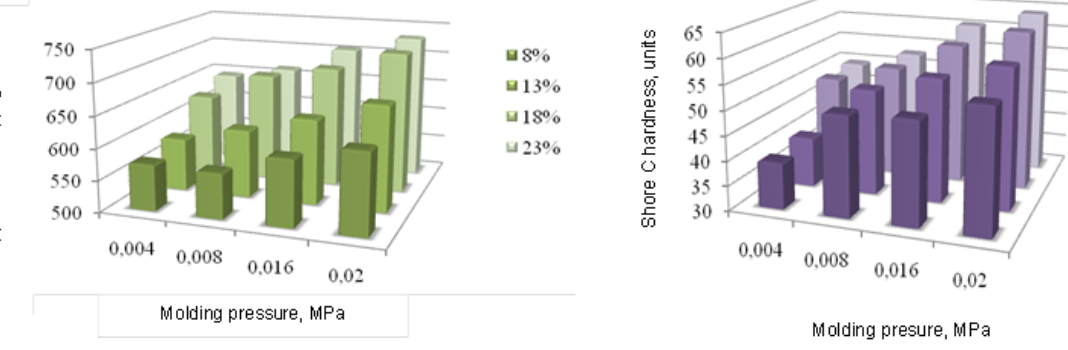
Figure 1: Variation in apparent density with molding pressure and content of polymer binder (8, 13, 18 and 23 wt.%).